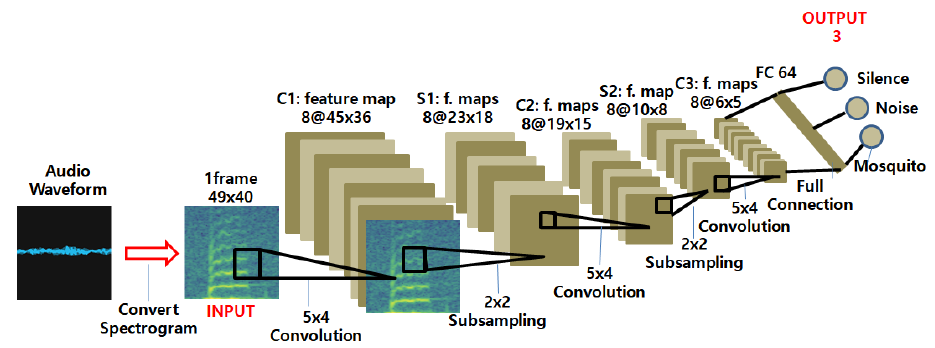
Figure 1. Neural network architecture for mosquito sound detection for the resource-limited hard- ware platform.